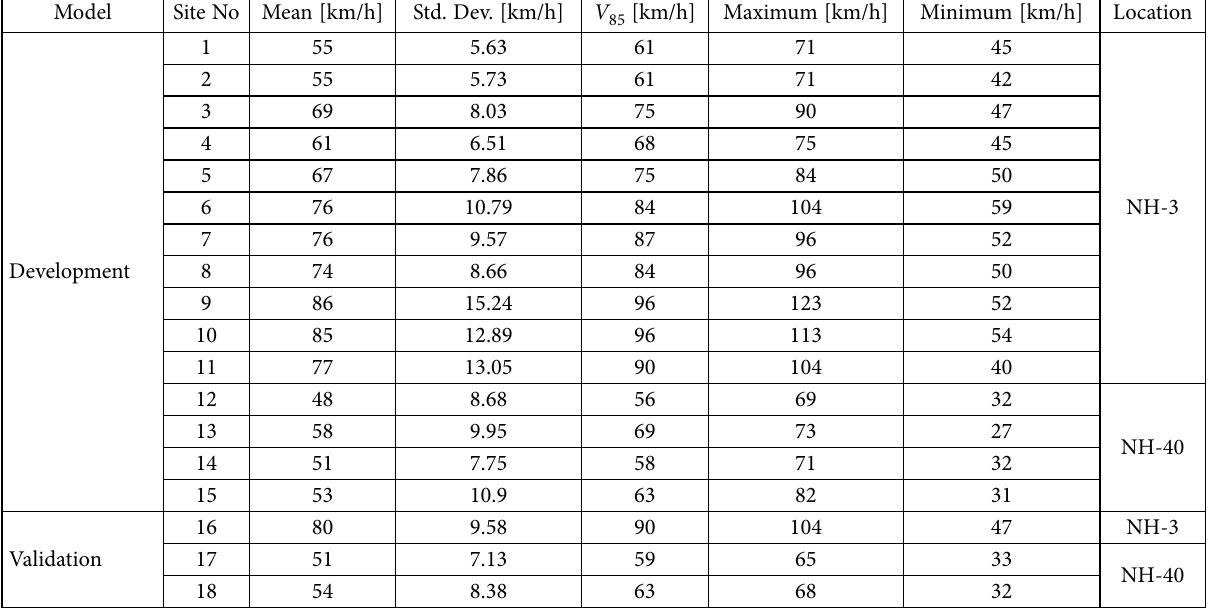
Table 2. Statistics of passenger car speed data